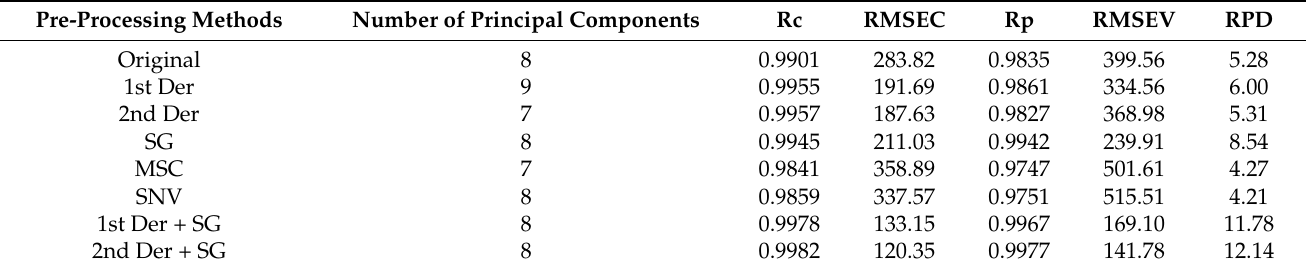
Table 2. The partial least squares method under different pretreatment methods for predicting the available nitrogen content of vermiculite